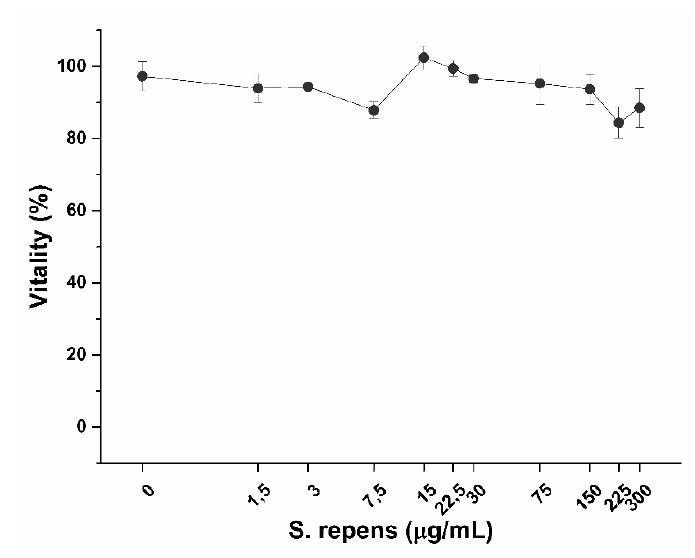
Figure 14. Effect on LNCaP prostatic cells vitality after 6 h exposure to SRO. ( n = 3).